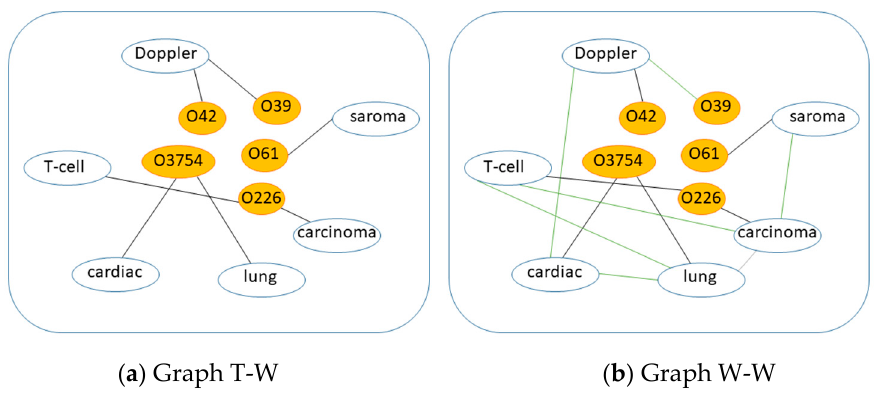
Figure 1. Yellow nodes represent text nodes, white nodes represent word nodes, black lines represent edges between text and words, and green lines represent edges between words and words.